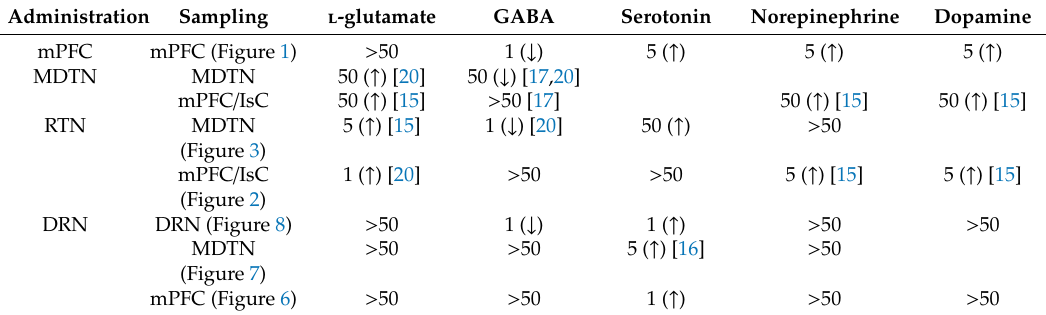
Table 1. Summary of threshold concentration of MK801.